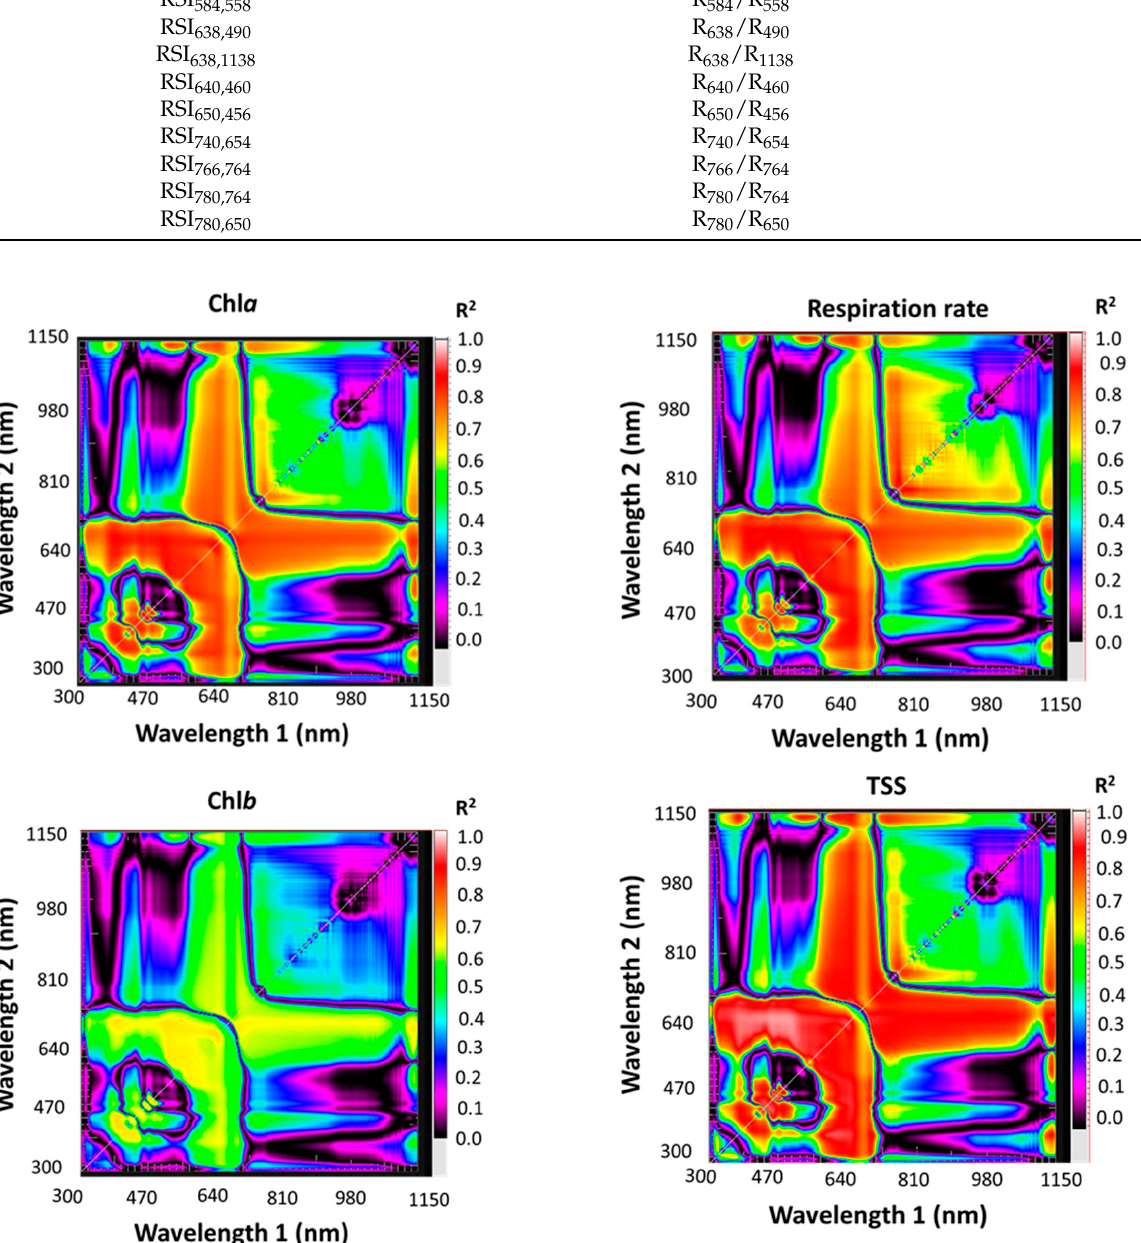
Figure 1. Correlation matrices displaying (R 2 ) values for possible dull wavelength together ranging from 302 to 1148 nm with Chl a, Chl b, respiration rate, TSS, and firmness of banana fruits. 2.6. Back-Propagation Neural Network (BPNN) The backpropagation neural network (BPNN) model is a kind of artificial neural net- work that is extensively applied. The BPNN is composed of three layers, as indicated by Schalkoff [39]. The ANN algorithm is a subclass of machine learning techniques that use numerous layers to progressively extract high-level characteristics from the raw input of SRIs (Figure 2). The network is composed of two hidden layers, the number of which is regulated by the accuracy of the regression. The concealed layers correspond to the “acti- vation” nodes and are often denoted by the term “weight.” The output layer displays the parameter’s expected value. At least 2000 iterations were used to train the network. To